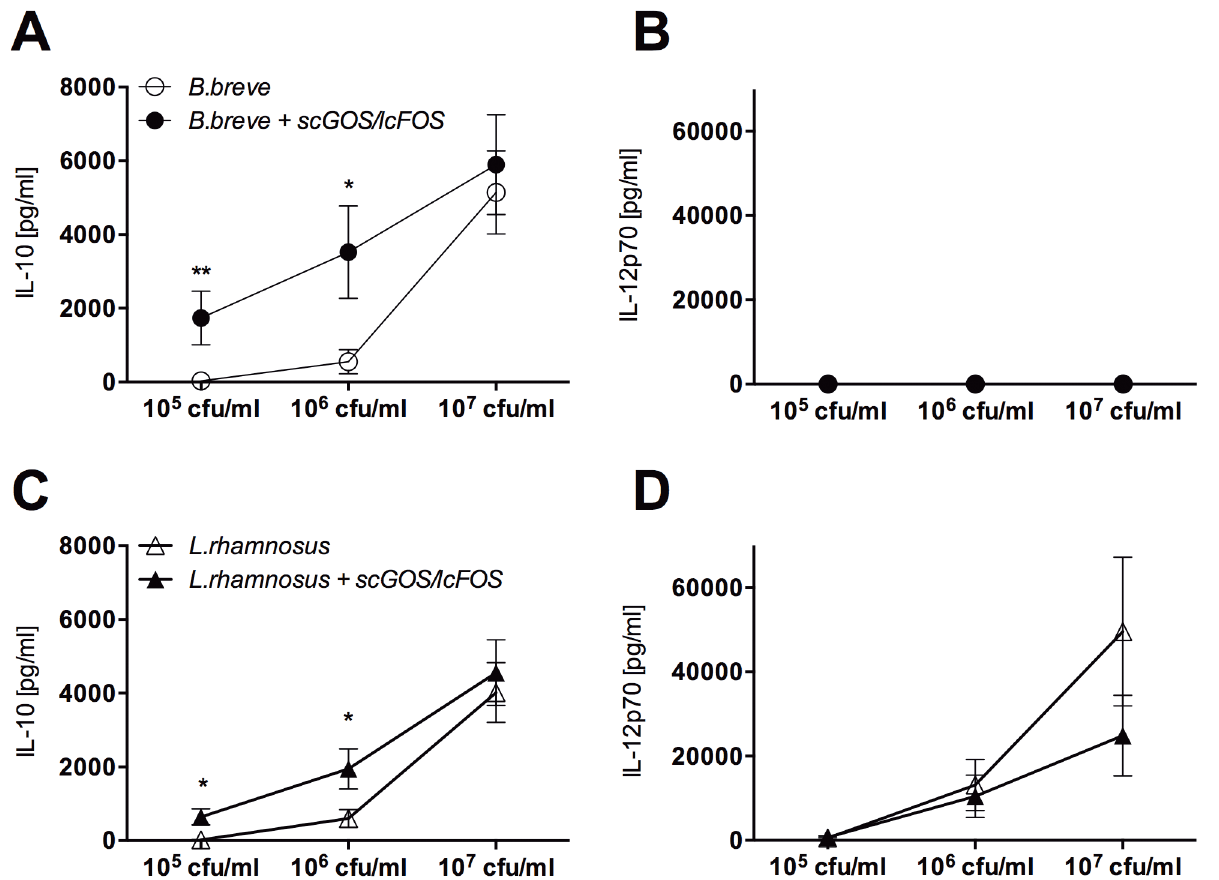
Fig 4. LAB-primed MoDC stimulated with scGOS/lcFOS are characterized by an enhanced release of IL-10 while no enhanced IL-12p70 secretion is detectable. Immature human MoDC were incubated with B . breve (clear dots, A, B) or L . rhamnosus (clear triangle, C, D) in different concentrations with (black marks) or without (clear marks) scGOS/lcFOS (5 mg/ml) for 24h. Supernatants were analyzed for secretion of IL-10 (A, C) and IL-12p70 (B, D) by ELISA. Results are presented as mean ± SEM, ten independent experiments are shown. * p < 0.05, ** p < 0.01, Mann Whitney test. LAB = Lactic acid bacteria, MoDC = monocyte-derived dendritic